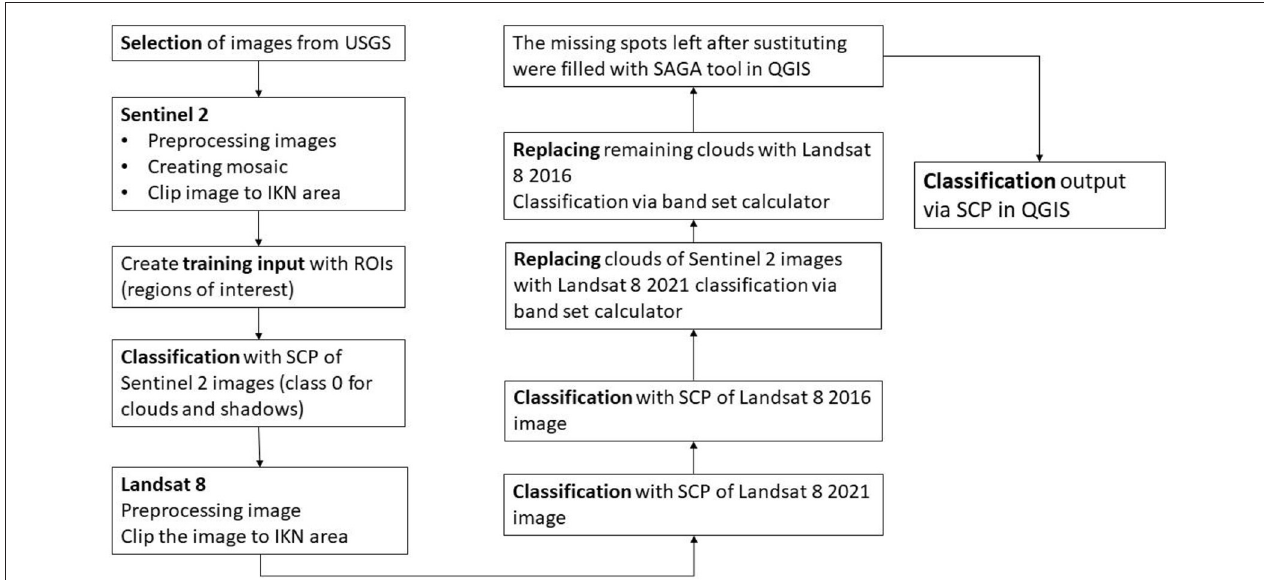
FIGURE 2 | Work flow of classification